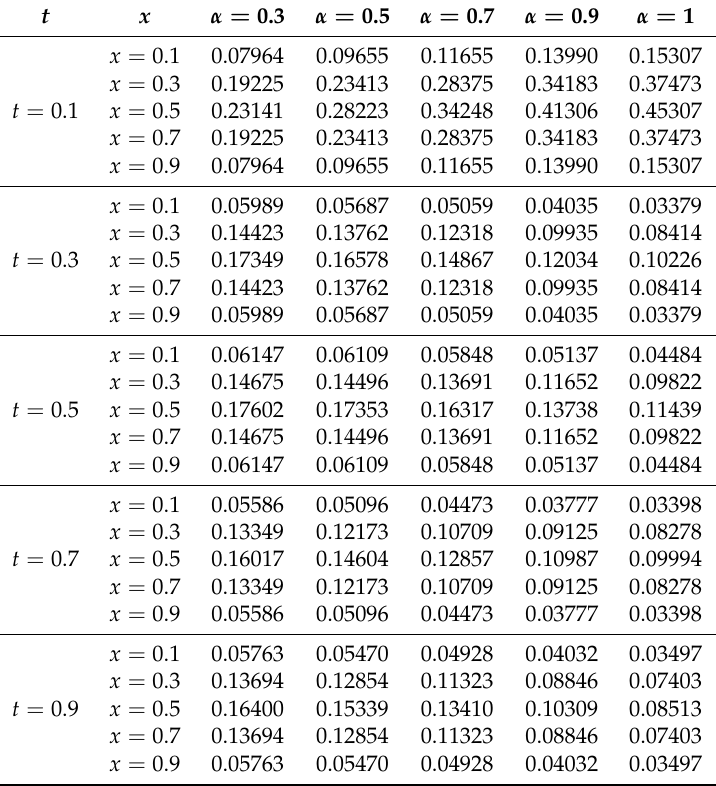
Table 3. Numerical results of the fractional Kolmogorov-Petrovsky-Piskunov (FKPP) equation with difference values of α